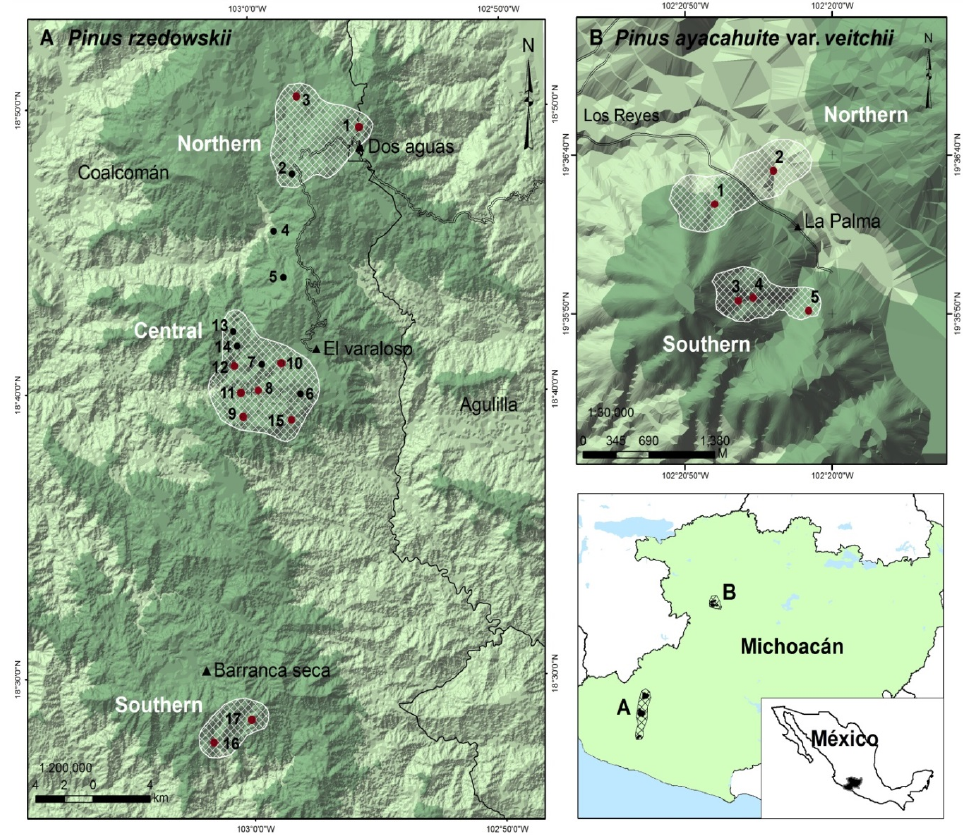
Figure 1. Geographical location of two pine species studied in Michoacán, Mexico: ( A ) three zones of Pinus rzedowskii populations (northern, central and southern); and ( B ) two zones of P. ayacahuite var. veitchii populations (northern and southern). The red circles indicate the populations for which cones were collected. The numbers denote the population code as described in Table 1.